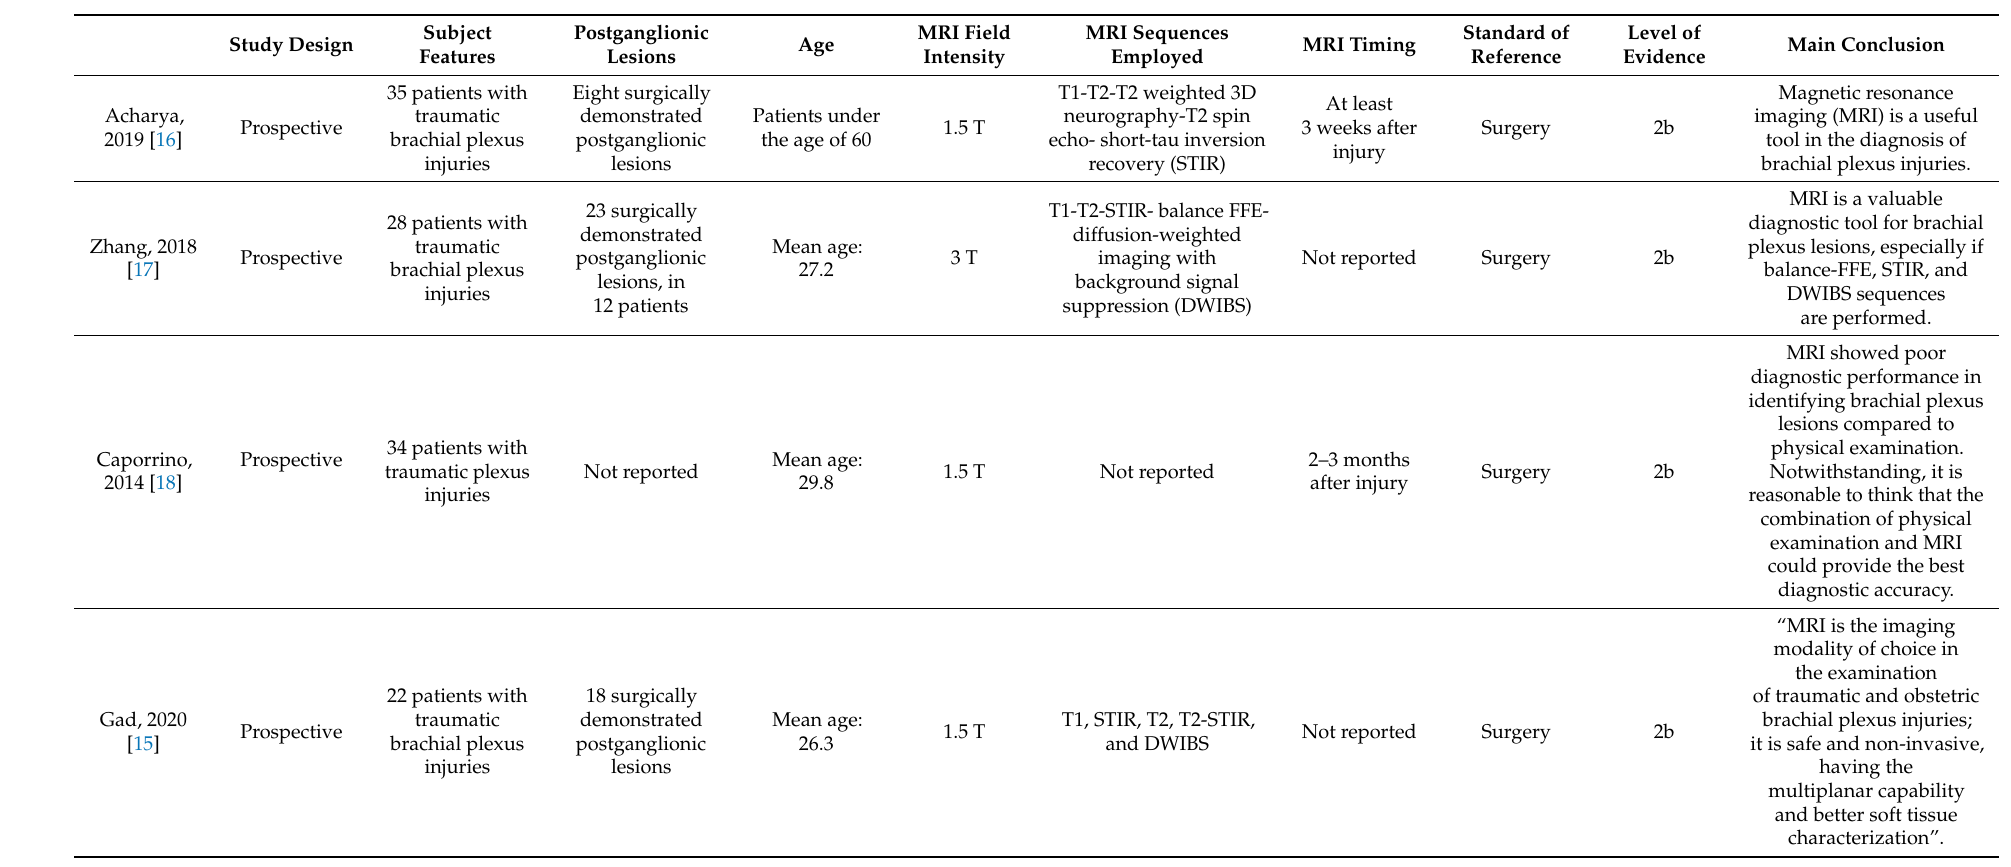
Table 1. Summary of included